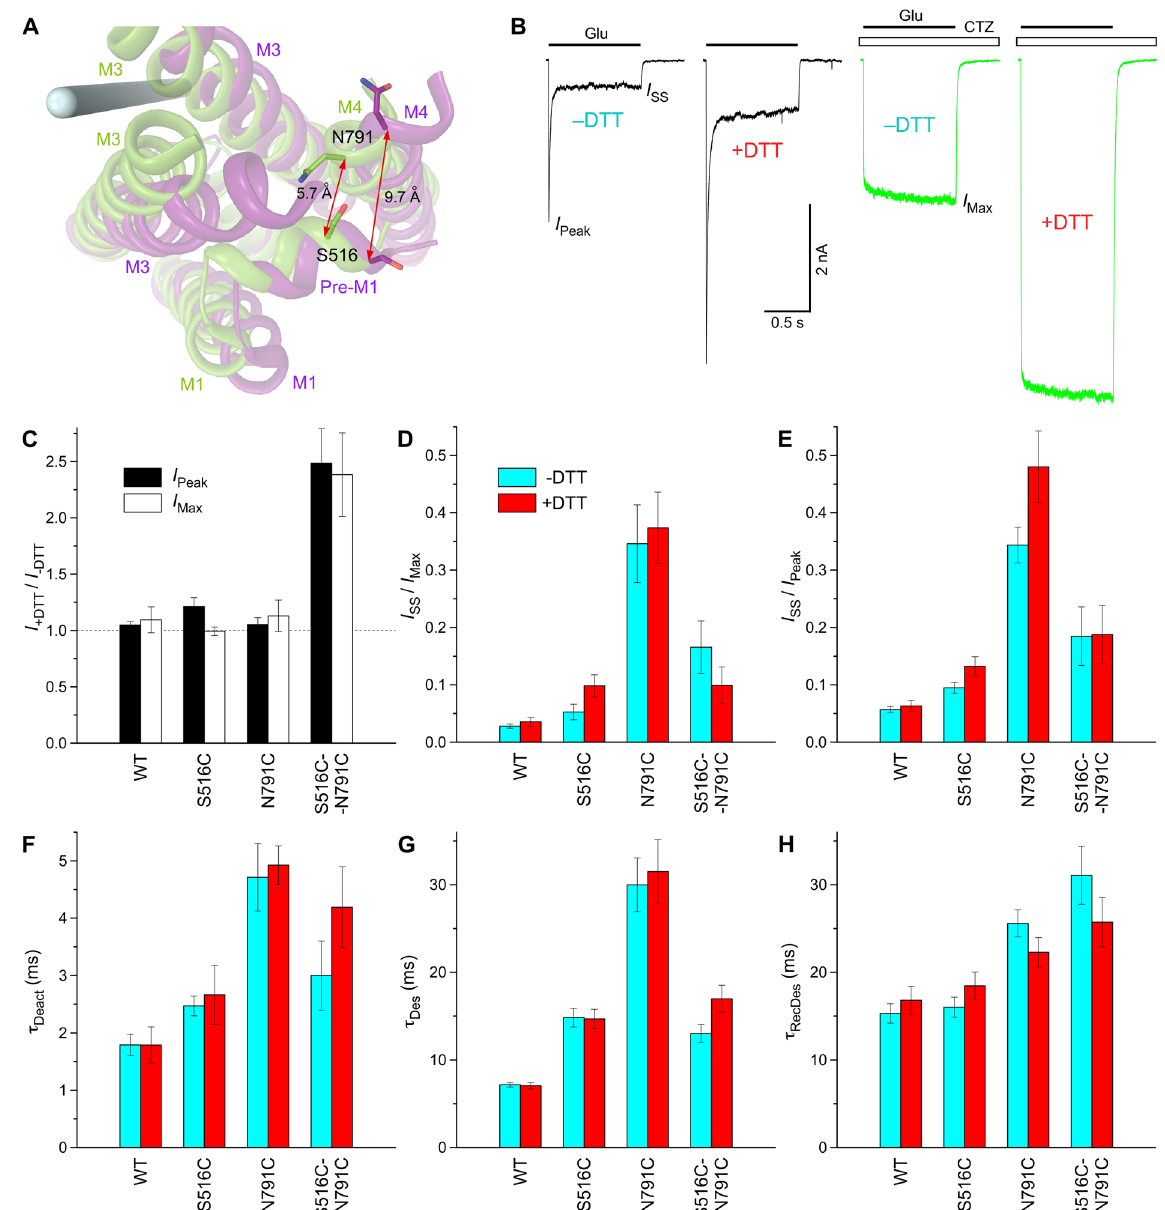
Figure 6. Crosslink between S516C and N791C. ( A ) Close-up view of the region encompassing noncompetitive inhibitor binding site in superposed structures of the MD simulated open (purple) and GluA2 apo closed (PDB ID: 5L1B) states. Side chains of S516 and N791 are shown as sticks. The pore axis is illustrated by a blue cylinder. Distances between C α ’s of S516 and N791 in the two structures are indicated by red arrows and labelled. ( B ) Representative whole-cell currents recorded at − 60 mV membrane potential from HEK293 cells expressing GluA2-S516C-N791C receptors in response to 1s applications of 3 mM Glu alone (black) or application of Glu in the continuous presence of 30 µ M CTZ (green), in non-reducing ( − DTT) or reducing ( + 1 mM DTT) conditions. ( C ) The ratio of the maximal current amplitudes measured in reducing versus non-reducing conditions in the absence ( I Peak , filled bars) or presence ( I Max , open bars) of CTZ for wild type (WT), single cysteine (S516C and N791C) or double cysteine (S516C-N791C) substituted GluA2 receptors. ( D–H ) The average fractions of non-desensitized channels, I SS / I Max ( D ) and I SS / I Peak ( E ), and the time constants of deactivation, τ Deact ( F ), desensitization, τ Des ( G ), and recovery from desensitization, τ RecDes ( H ) measured in non-reducing ( − DTT, cyan bars) or reducing ( + DTT, red bars) conditions. Error bars represent